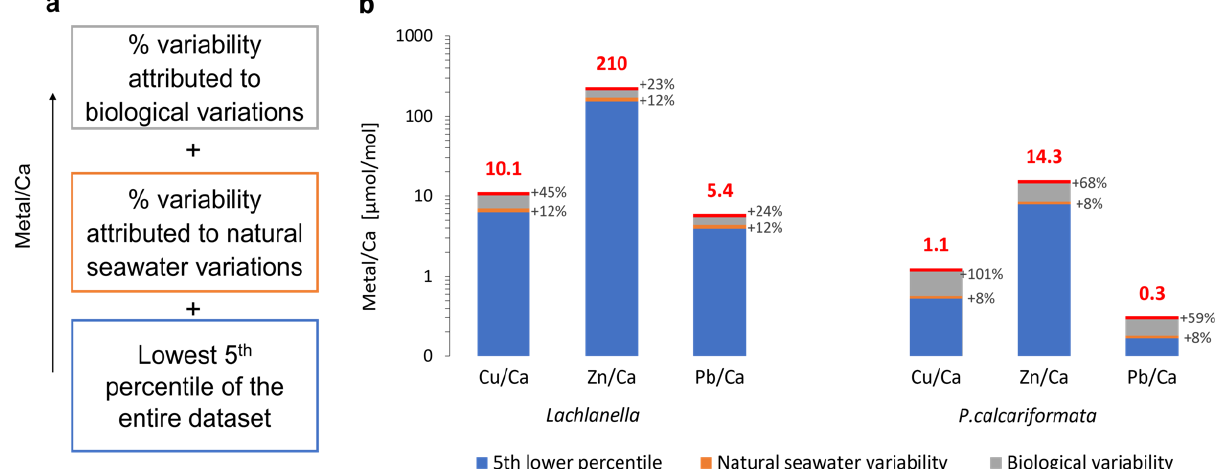
Figure 4. ( a ) Schematic illustration of the methodological approach for calculating the BAL values. ( b ) Calculated BAL values (marked in red) of each HM for the two species (logarithmic scale). These levels define the minima background concentrations for each HM within a certain area, expressed as metal/Ca. The BAL was defined as the 5th lower percentile metal/Ca calculated from the entire LA-ICPMS dataset (blue) plus the percent of metal/Ca attributed to natural seawater variability (orange) plus the percent of metal/Ca attributed to natural biological variations calculated by culturing experiments (gray) (see text for details).